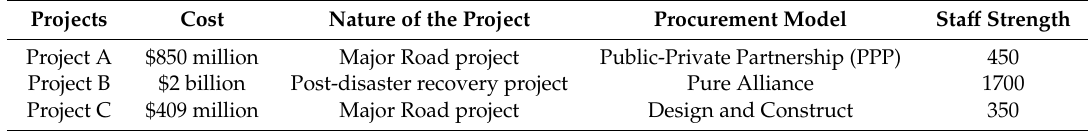
Table 1. Project